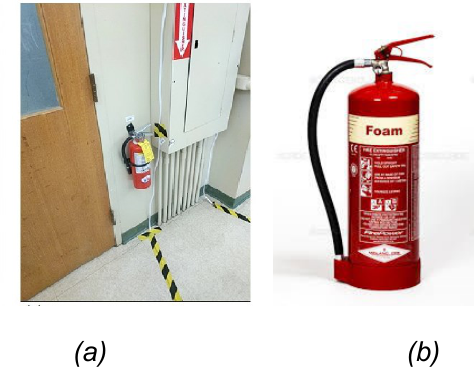
Figure 1. An example of fire extinguisher (a) captured by the operator in an actual room; (b) from Google Image